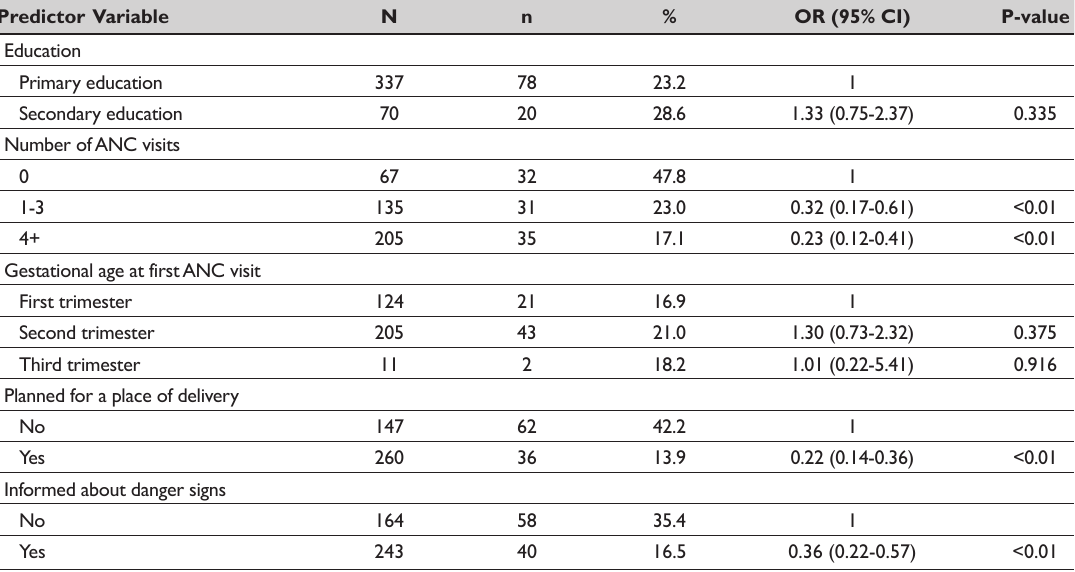
Table 2 : Association between home delivery, maternal level of education and uptake of ANC services (N=407) Predictor Variable